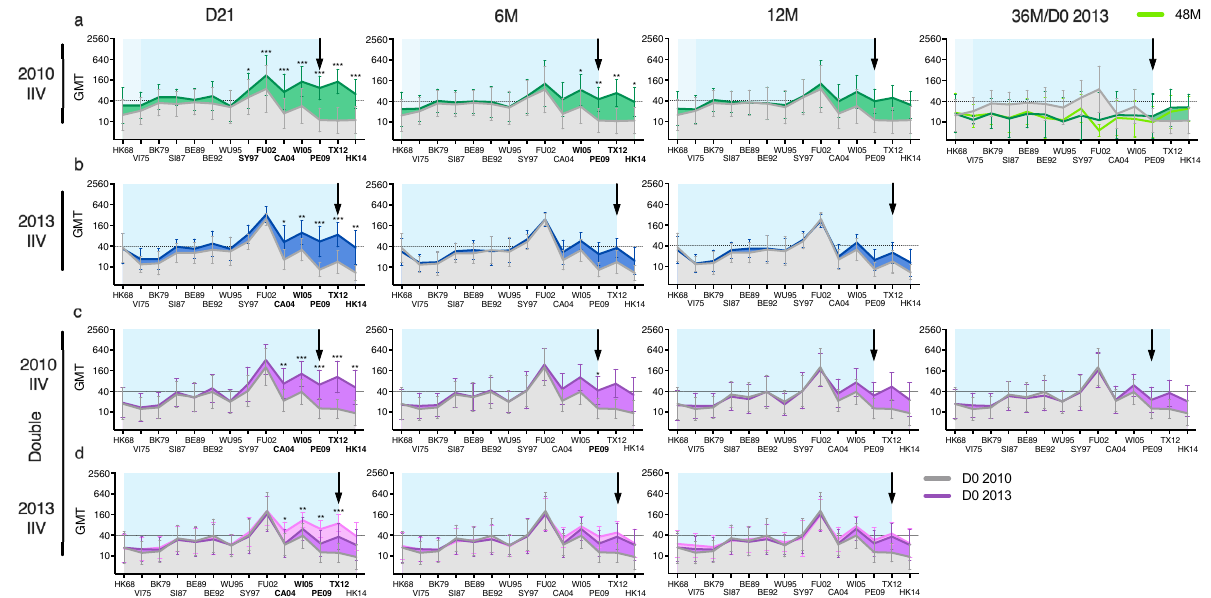
Fig. 4 The A/H3N2-speci fi c hemagglutination inhibition (HI) antibody landscapes after vaccination with inactivated in fl uenza vaccines (IIV) in adults. Antibody landscapes were generated using the groups ’ geometric mean HI titre (GMT) against 14 antigenically distinct in fl uenza A/H3N2 viruses (see Table 1 for the strains used). Error bars represent the 95% con fi dence intervals of the GMTs. The pre-vaccination GMTs at day (D)0 are displayed in grey. a Antibody landscapes of adults vaccinated with single IIV in 2010, n = 10 (single 2010 IIV) at D21, 6 months (M), 12 M, 36 M (equivalent to D0 in 2013) (dark green), and 48 M (equivalent to 12 M in 2013) (light green) post-IIV. b Antibody landscapes of adults vaccinated in 2013, n = 10 (single 2013 IIV) at D21, 6 M and 12 M post-IIV (dark blue). ( c – d ): Antibody landscapes of adults vaccinated in both 2010 and 2013 (double IIV), n = 10, at D21, 6 M, 12 M and 36 M after 2010 IIV (dark purple) ( c ) or after 2013 IIV (light purple) ( d ). The individual vaccinee landscapes can be found in Supplementary Figure 2b – d. The black arrow indicates the vaccination virus, and the dotted line indicates the HI titre of 40. The viral exposure period is shown in blue based on the group ’ s median age, and light blue indicating the oldest individual in the group. Pre- and post-IIV titres were compared using nonparametric repeated measure Friedman test with Dunn ’ s multiple comparison correction for each vaccination group. * P < 0.05, ** P < 0.01, *** P = <